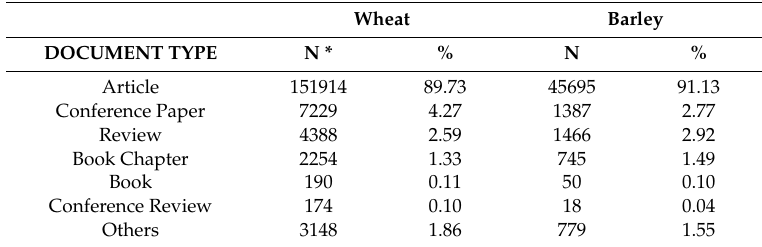
Table 4. Distribution of document types for research on wheat and